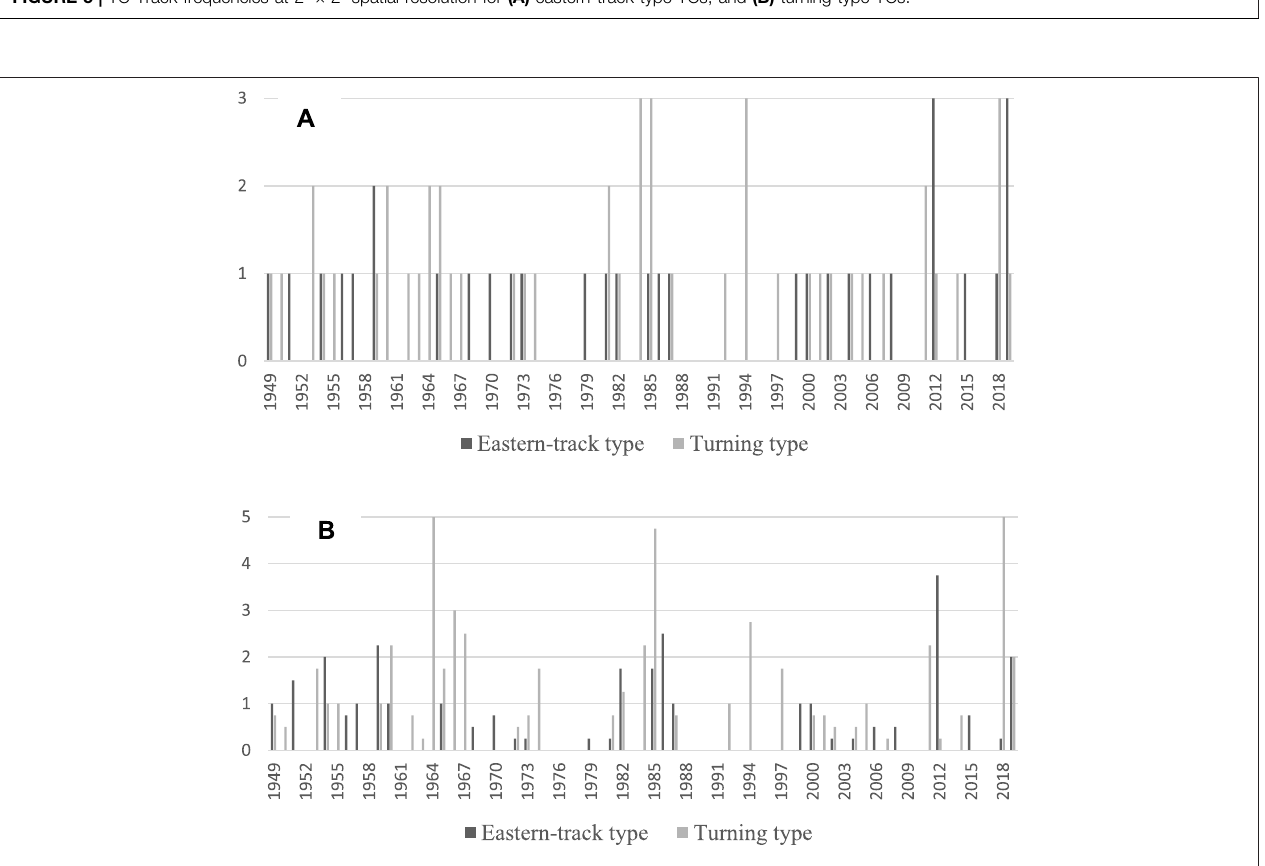
FIGURE 6 | Time series of (A) TC number and (B) in fl uence days of the two types of northward-moving TCs.